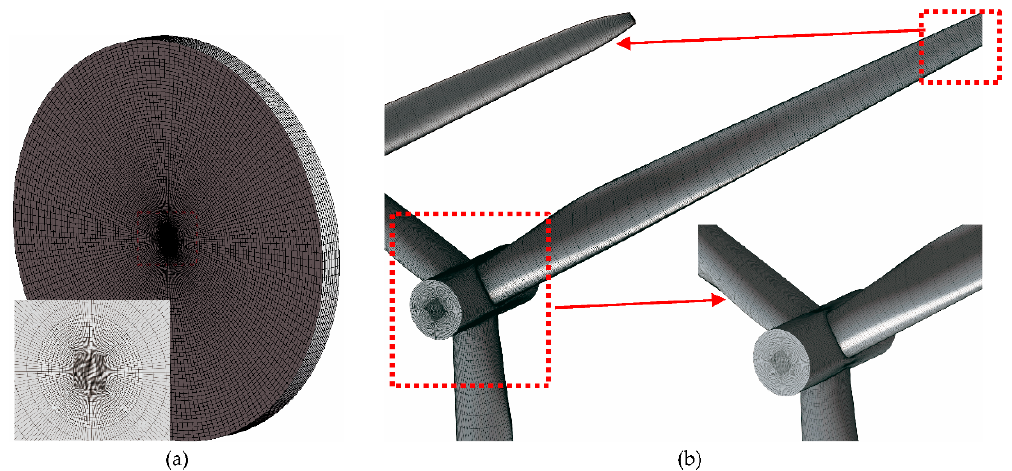
Figure 4. Computational mesh for NREL 5-MW wind turbine; ( a ) rotor cylinder; ( b ) blade surface mesh.